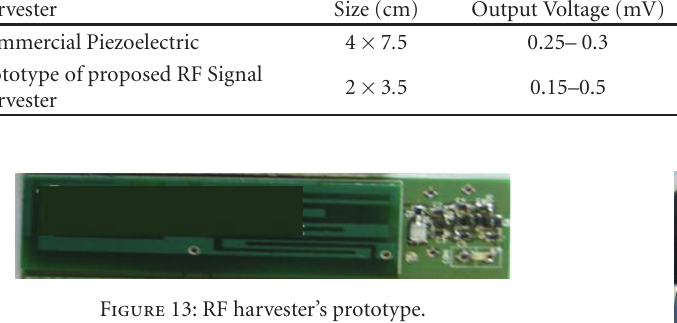
Figure 13: RF harvester’s prototype.